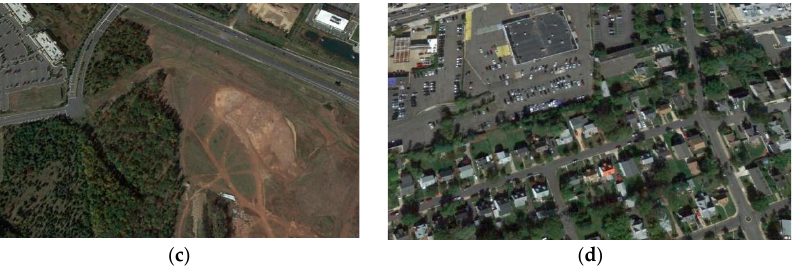
Figure 10. Remote sensing images in NWPU-VHR-10 dataset. ( a , b ) are positive pictures and negative ( c , d ) below.